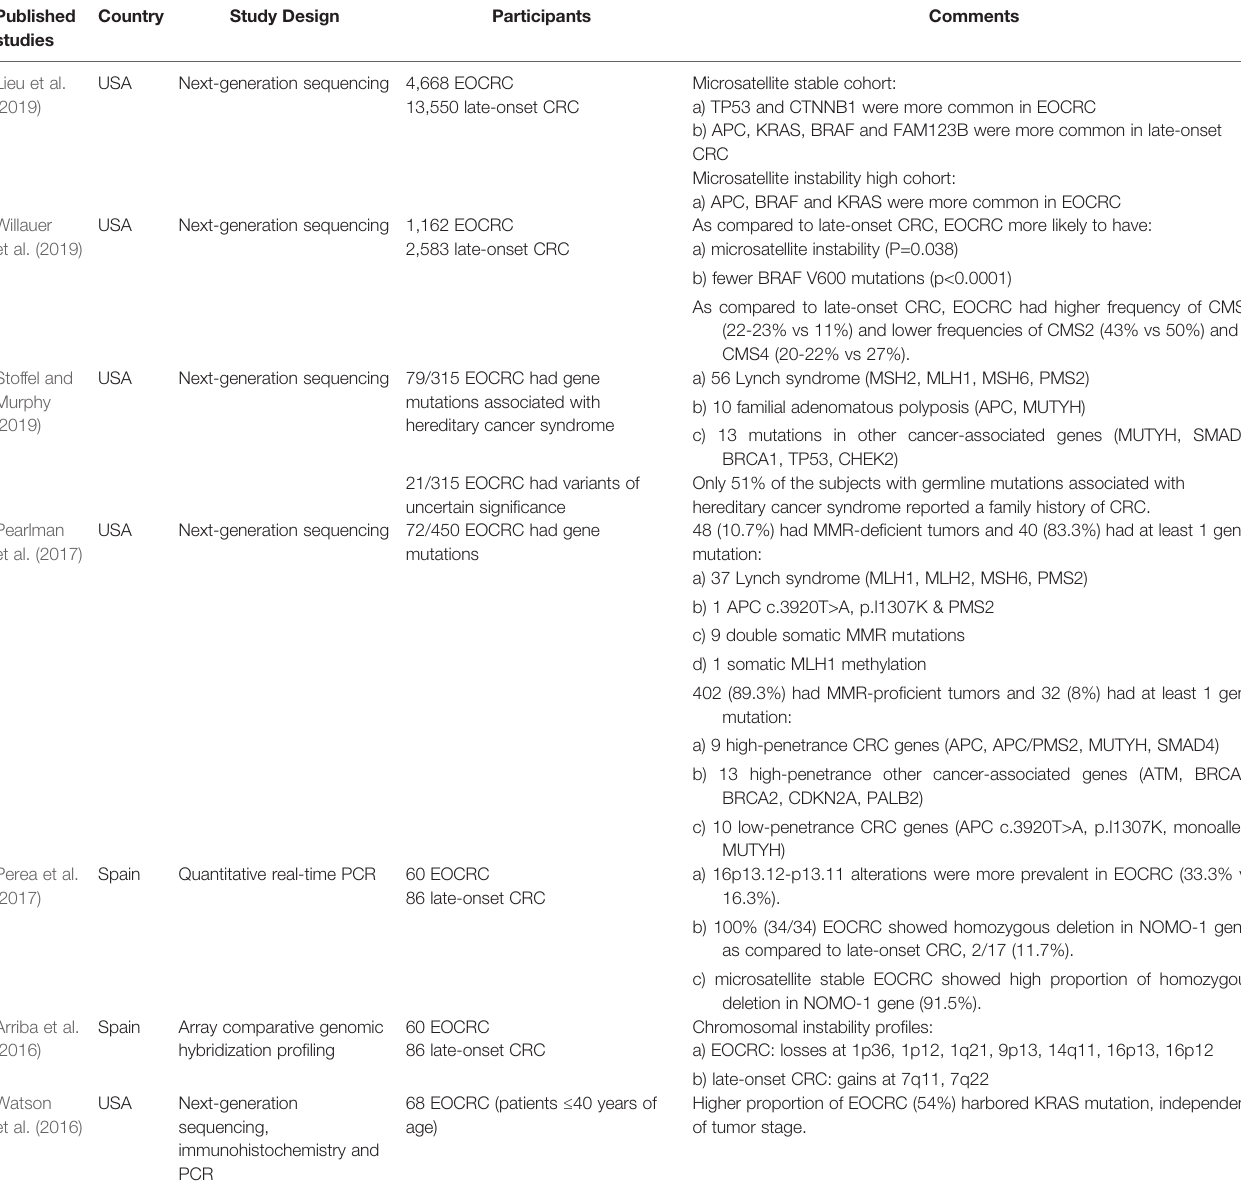
TABLE 3 | Recent published studies on germline mutations in EOCRC